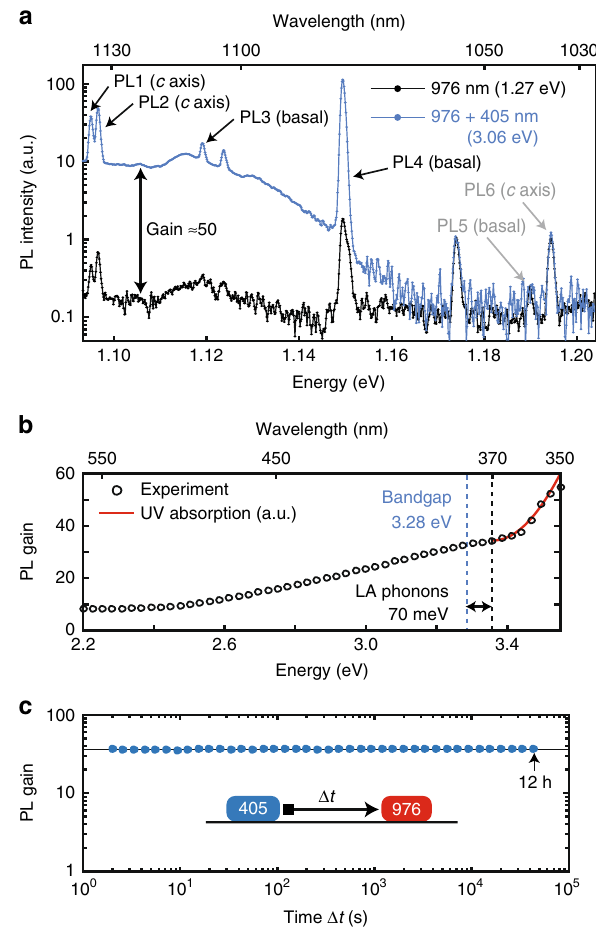
Fig. 1 Effect of near-bandgap illumination on 4H-SiC divacancies. a PL spectrum with 976 nm excitation of the various divacancies in 4H-SiC, as designated in ref. 6 , without and with continuous illumination at 405 nm ( ≈ 5 mW optical power). All the observed PL lines except PL5 and PL6 are enhanced by the UV excitation, including both c axis and basal defects. b Gain in the PL signal (integrated across PL1 – 4) as a function of excitation wavelength (energy) around the 4H-SiC bandgap (3.28 eV at 5 K 49 ). Power